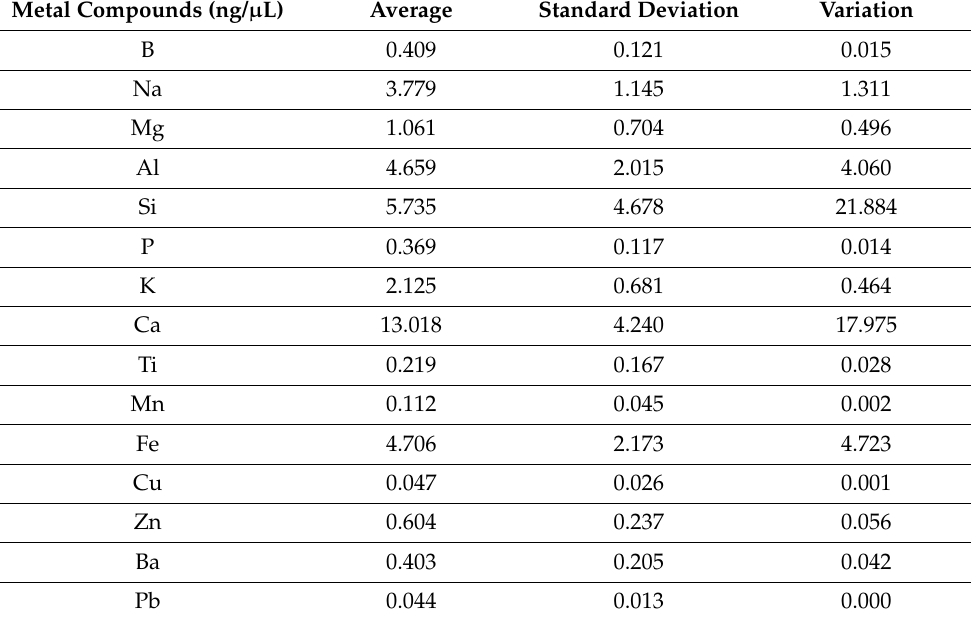
Table 5. Total metal components in the TSP samples at 20 m and 70 m.